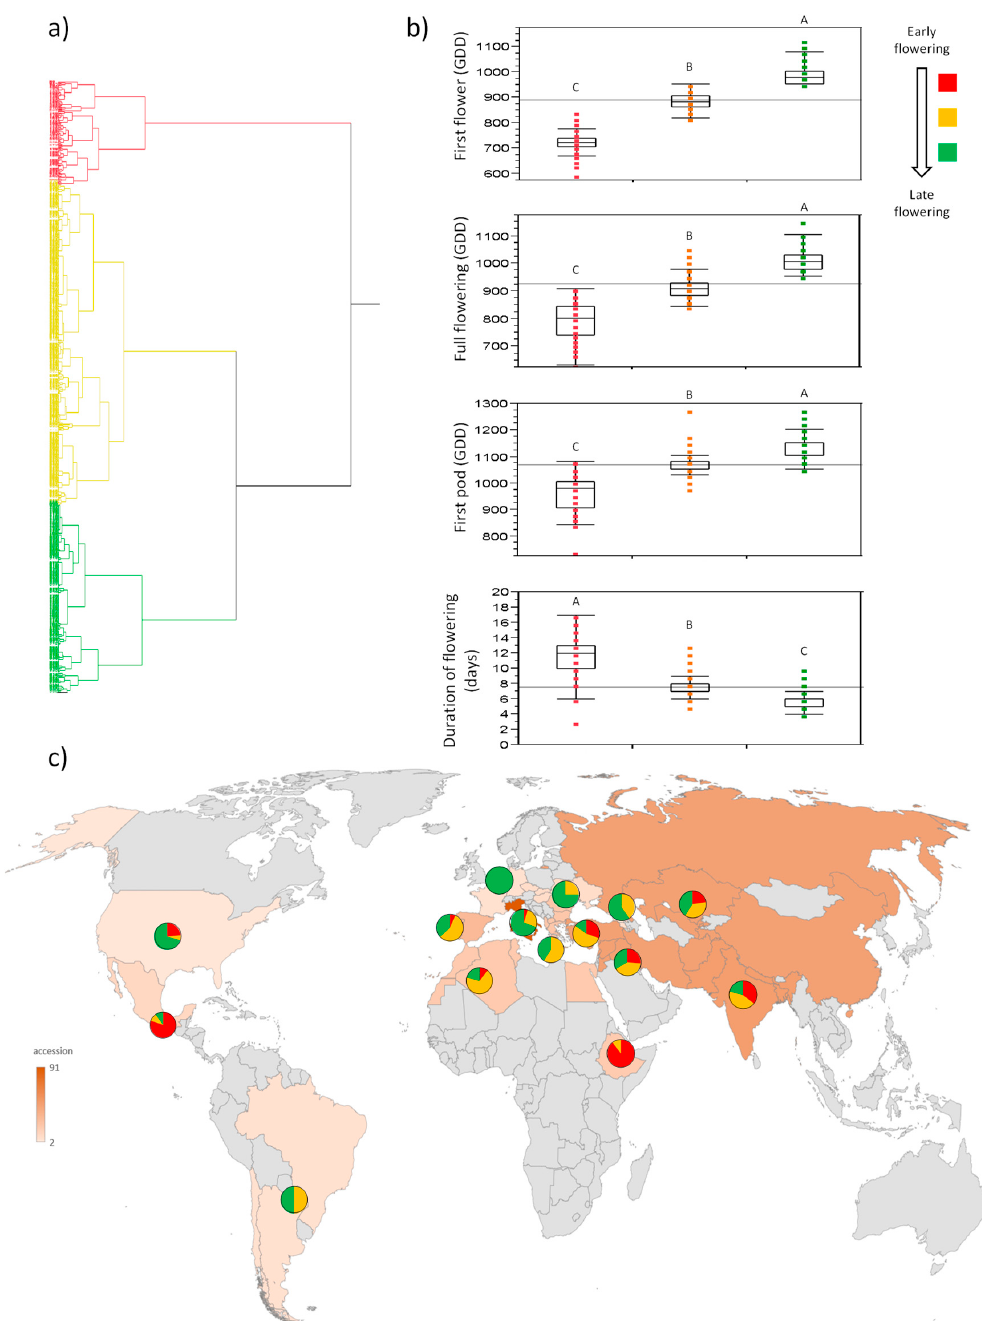
Figure 5. Hierarchical cluster analysis for the flowering traits (days to first flower, days to full flowering, days to first pod and duration of flowering) of the UNIVPM_Ca_core2 panel. ( a ) Dendrogram of the 480 lines based on their flowering traits, as the early, intermediate and late-flowering clusters (in red, yellow and green, respectively). ( b ) Box-plots illustrating the differences in the flowering traits among the lines belonging to the three clusters illustrated in ( a ). The boxes show the first, second (median) and third quartiles. Different capital letters above the boxes in each plot indicate significant difference between clusters for that trait ( p < 0.05; Student’s t -tests). ( c ) Pie charts for the geographic areas for the proportions of lines belonging to the three clusters illustrated in ( a ). The lines from Malawi and Australia are not shown because these countries had only one line in the UNIVPM_Ca_core2 panel. Geographic areas are colored on the basis of the number of genotypes in them; the higher the number of genotypes, the darker the shade of the color.